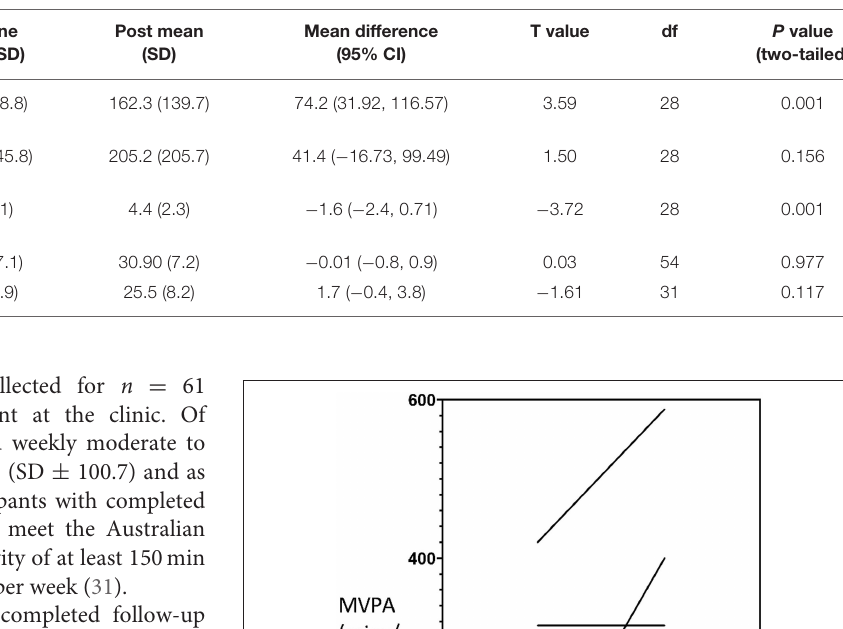
TABLE 2 | Pre- and post-outcome measures.